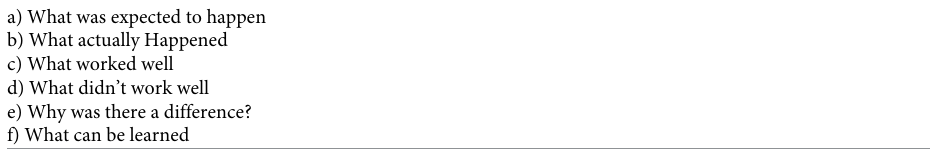
Table 2. Guiding questions for after action review of Lassa fever outbreak, Tonkolili district, Sierra Leone,